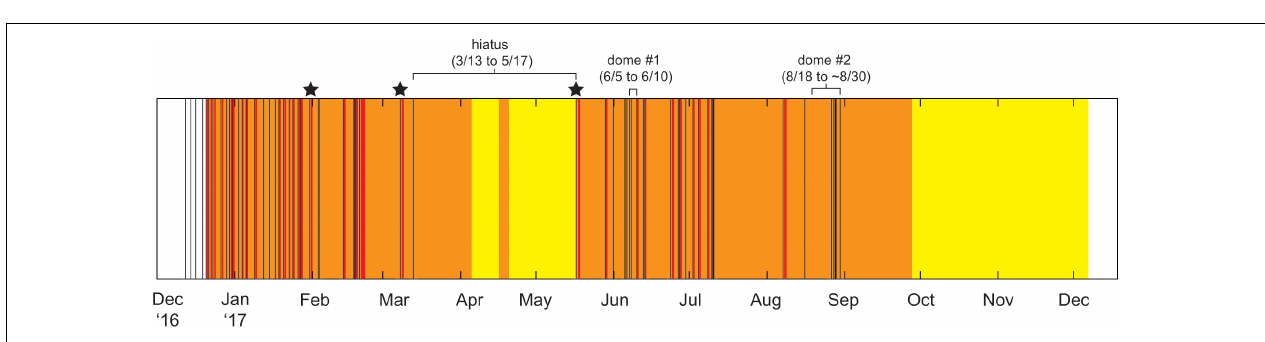
FIGURE 2 | Timeline of 2016–2017 Bogoslof eruption, showing explosive events as vertical black lines, and the aviation color code as colored bars (no color = unassigned). Stars indicate explosive events that produced reported ashfall on land or